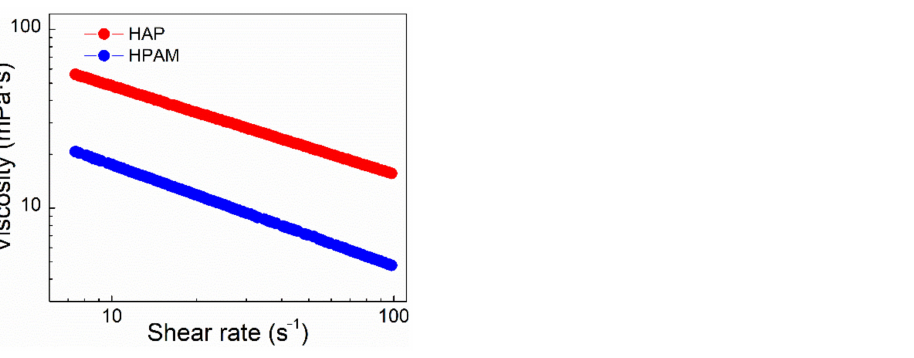
Figure 6. The effect of shear rate on apparent viscosity of polymer solutions at 75 ◦ C. (Polymer concentration, 0.175%; salinity, 3.26 × 10 5 mg/L).